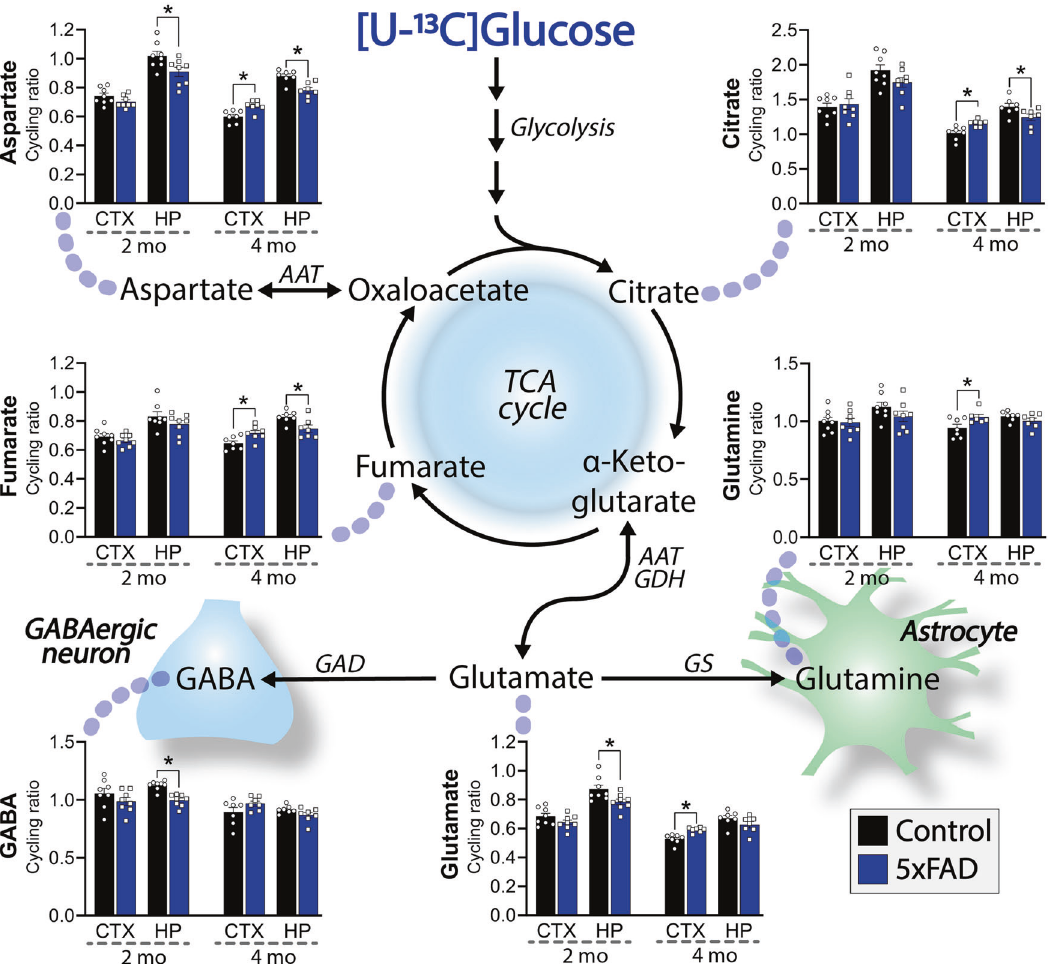
Fig. 3 Disrupted glucose metabolism in cerebral cortical and hippocampal brain slices of 5xFAD mice. Cycling ratios, re fl ecting the rate of the TCA cycle, calculated from metabolism of [U- 13 C]glucose in acutely isolated cerebral cortical and hippocampal brain slices of 2 and 4 months (mo) old 5xFAD mice. GABA and glutamine are selectively synthesized in neurons and astrocytes, respectively. AAT: aspartate aminotransferase, CTX: cerebral cortex, GAD: glutamate decarboxylase, GDH: glutamate dehydrogenase, GS: glutamine synthetase, HP: hippocampus, PAG: phosphate-activated glutaminase. Mean ± SEM, n = 6 – 8, Student ’ s unpaired t -test with Benjamini-Hochberg